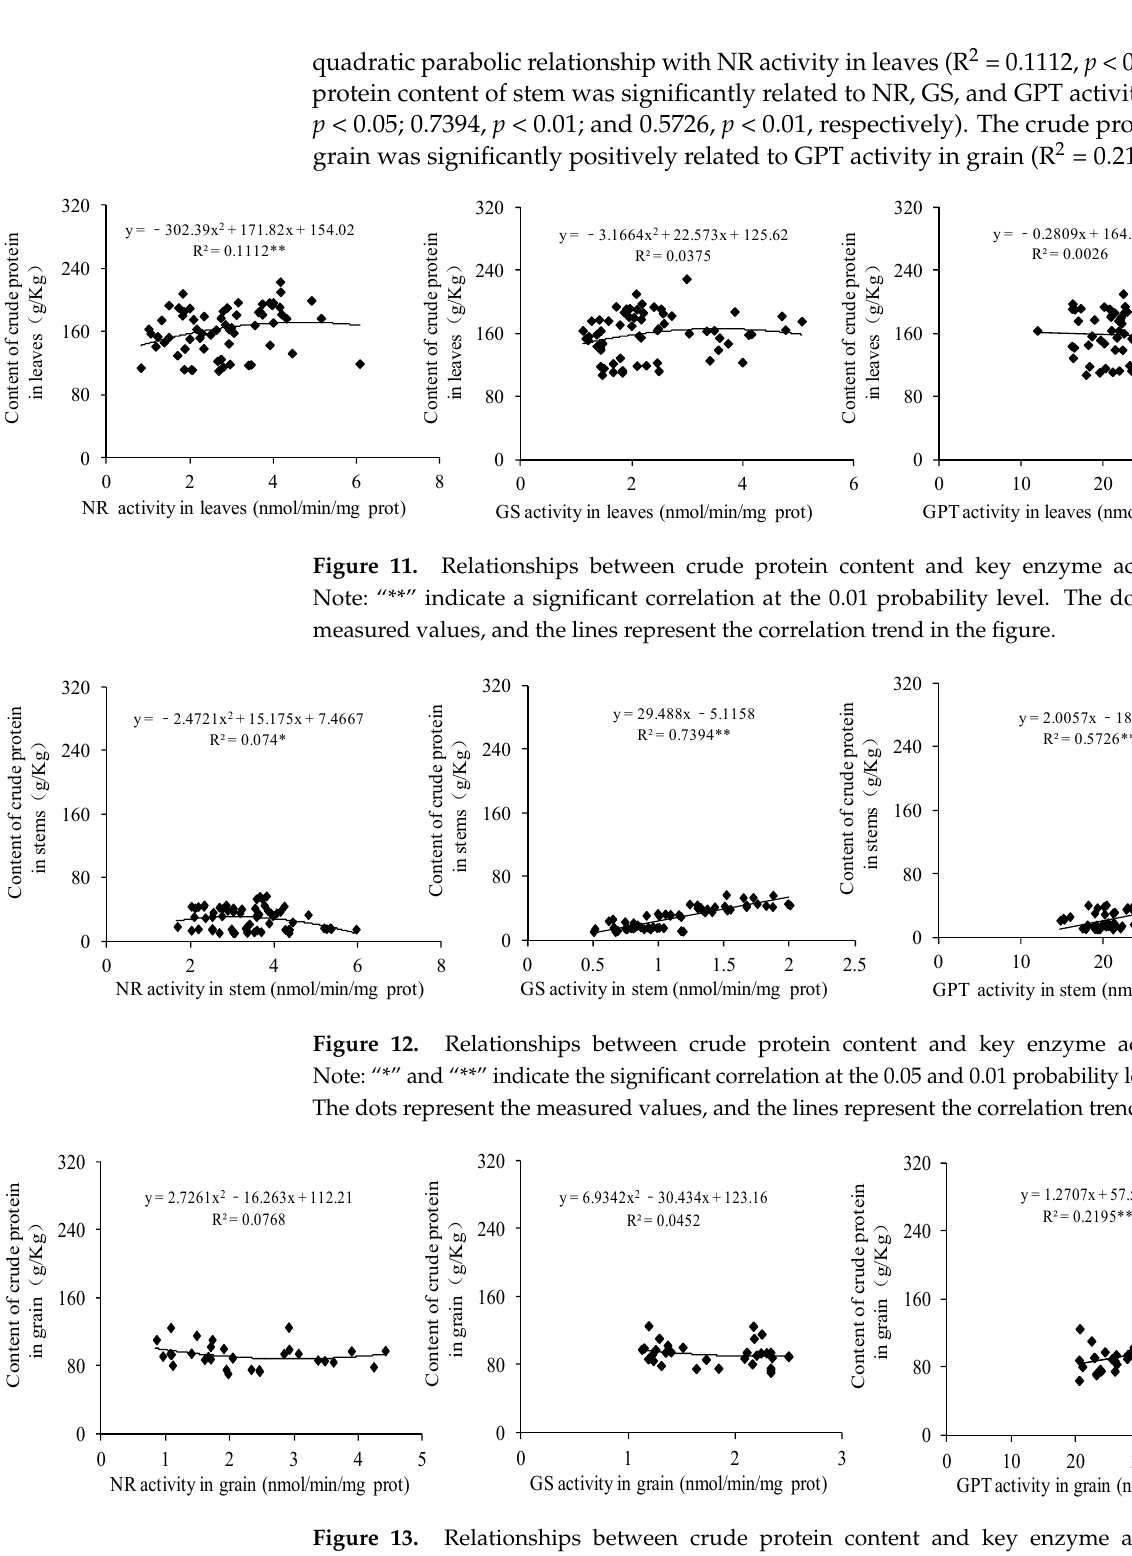
9 of 15 Figure 9. Relationships between plant density and key enzyme activity. Note: “*” indicate a signif- icant correlation at the 0.05 probability level. The dots represent the measured values, and the lines represent the correlation trend in the figure. Figure 10. Relationships between fertilization and key enzyme activity. Note: “*” indicate a signifi- cant correlation at the 0.05 probability level. The dots represent the measured values, and the lines represent the correlation trend in the figure.